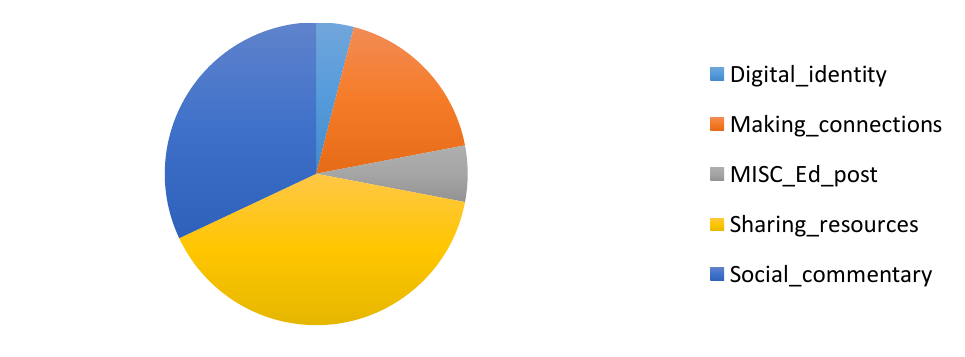
Figure 2- Louise's Twitter